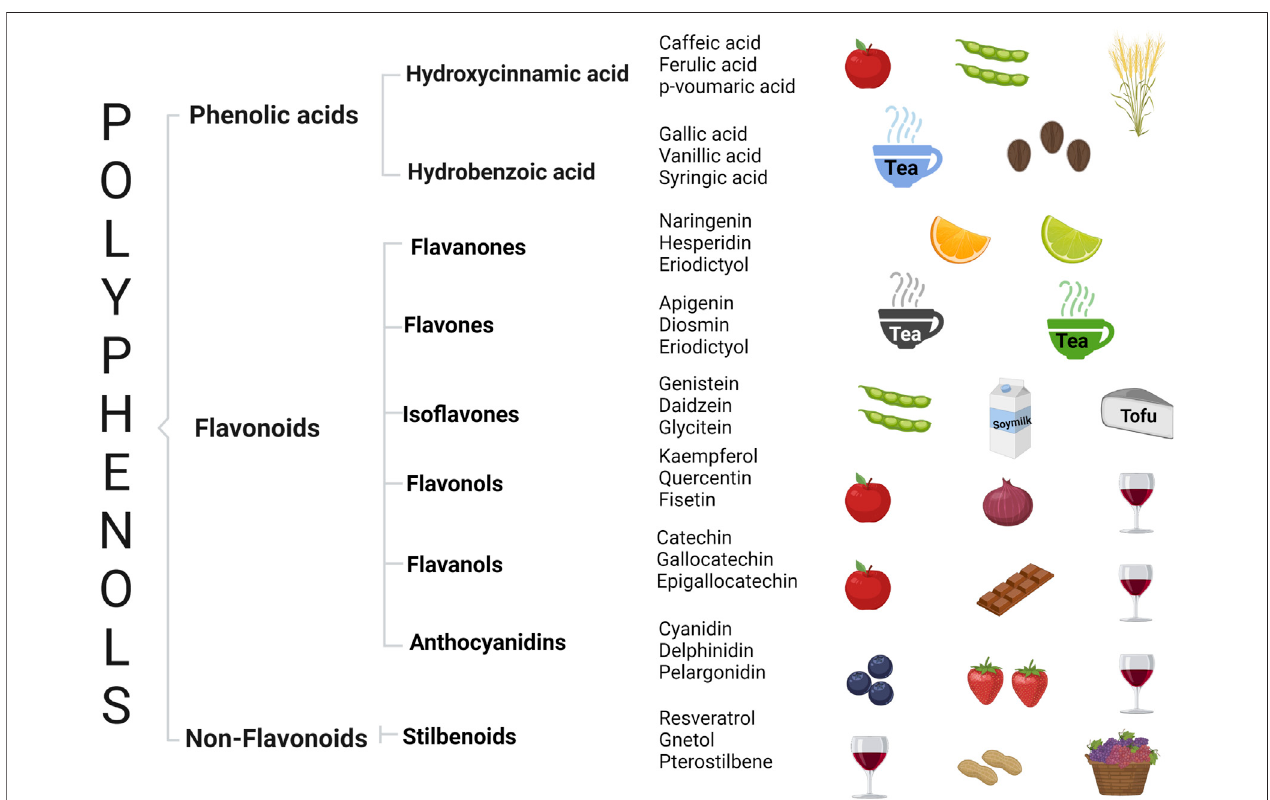
FIGURE 1 | General classi fi cation of polyphenols, representative compounds by group, and their associated rich food sources.